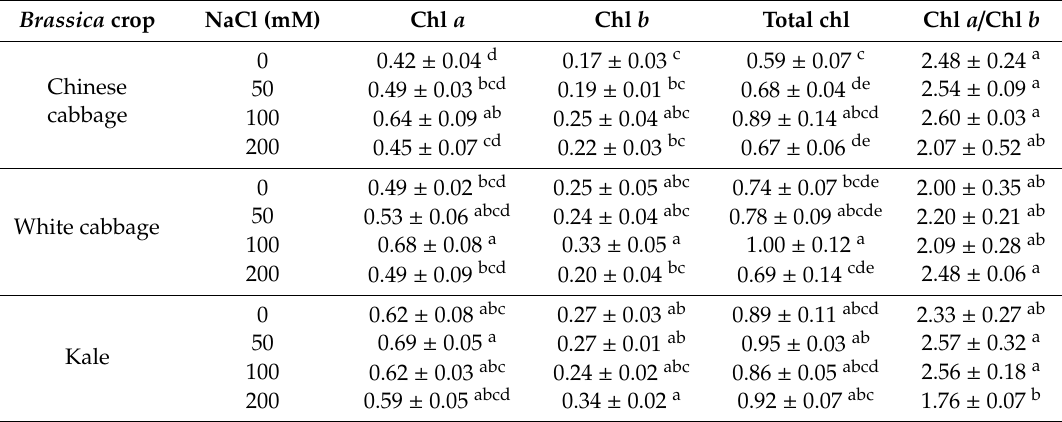
Table 1. Chlorophylls (Chl) levels (mg g − 1 fresh weight (fw)) upon treatments with increasing concentrations of NaCl (mM). Data are averages ± SD ( n =